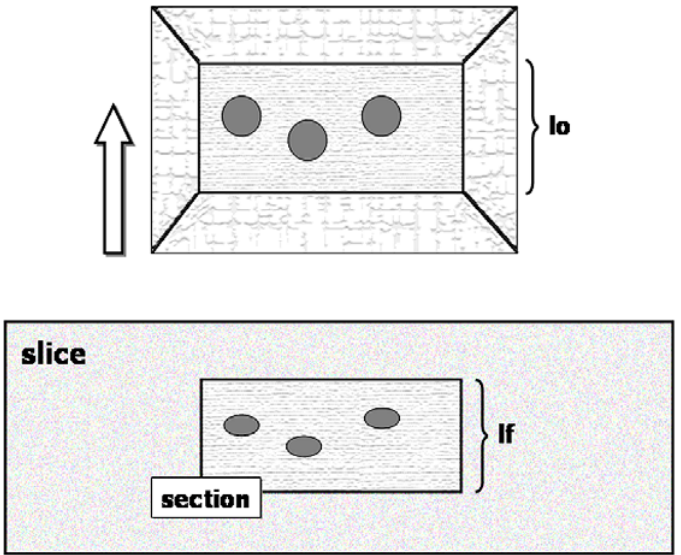
Fig. 4 – Effect of section compression. Length of the block face in the direction of the cutting stroke, lo, and the same compressed length on the section, lf. The section has been compressed by the compression factor (fc=lf/lo) (based on Weibel